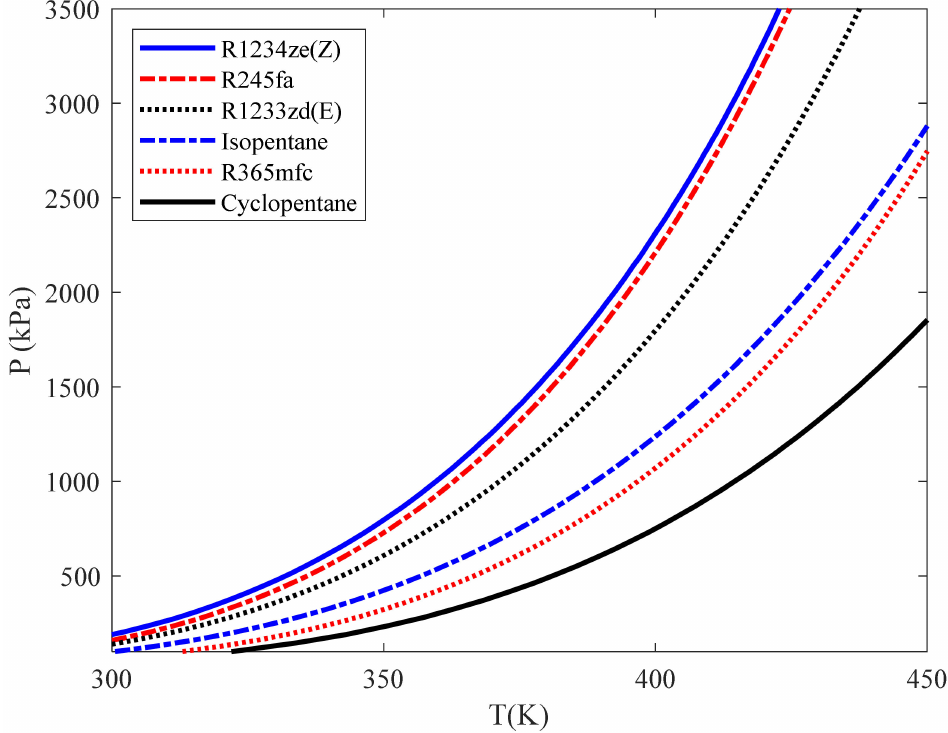
Figure 3. Saturation vapor pressure–temperature(P–T)